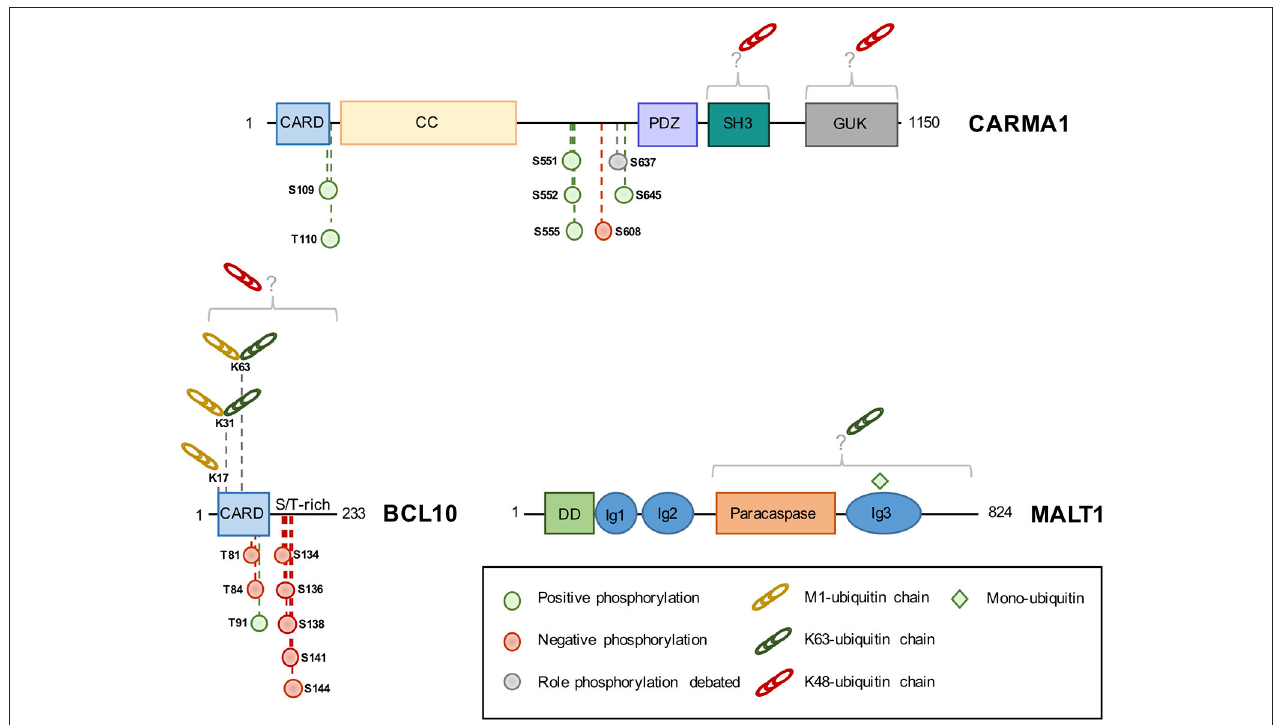
FIGURE 2 | The domain structure of CBM components and their identified phosphorylation and ubiquitination sites. Phosphorylation of CBM components can positively (green circle) or negatively (red circle) influence NF- κ B, although the role of some sites is debated (gray circle). K 48 -linked ubiquitin linked (red chains) chains lead to protein degradation, while K 63 or M 1 -linked chains (green and yellow chains, respectively) modulate activity. Monoubiquitination (green square) activates MALT1 protease activity. CARD, Caspase recruitment domain; CC, Coiled-Coil; PDZ, PSD95-DLG-ZO1 homology domain; SH3, Src homology 3; GUK, guanylate kinase domain; S/T-rich, serine/threonine-rich domain; DD, death domain; Ig, immunoglobulin-like domain; K, lysine; M, methionine.